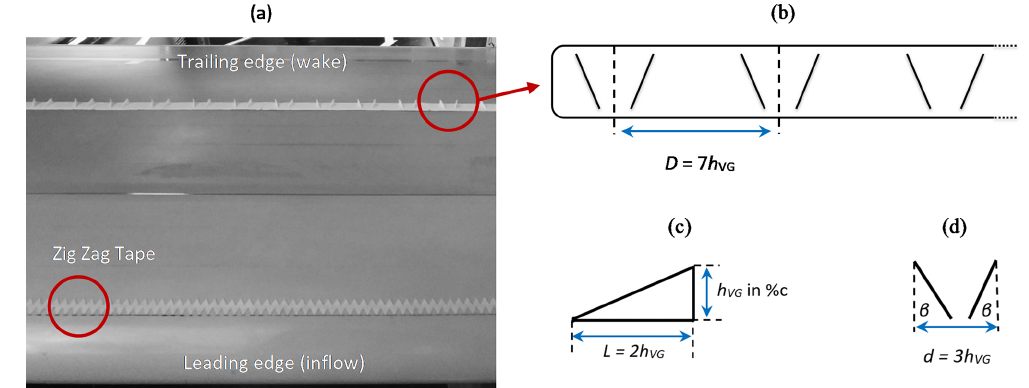
Figure 3. NACA63(3)618 during wind tunnel tests. (a) Top view on suction side with ZZ tape and VG array. (b) VG panel including spacing between VGs (with permission from SMART BLADE GmbH). (c) Side view of single vane. (d) Top view of single